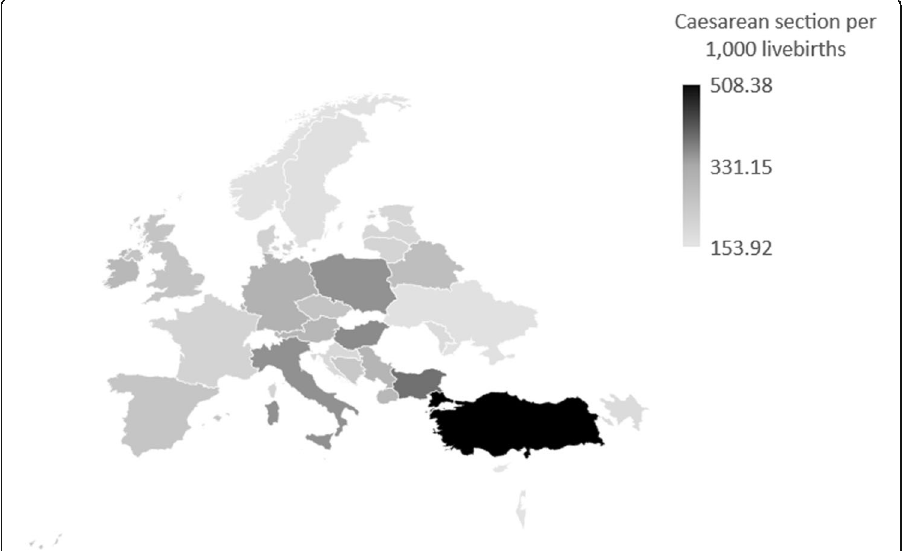
Fig. 2 Caesarean sections per 1000 livebirths in various European Countries,